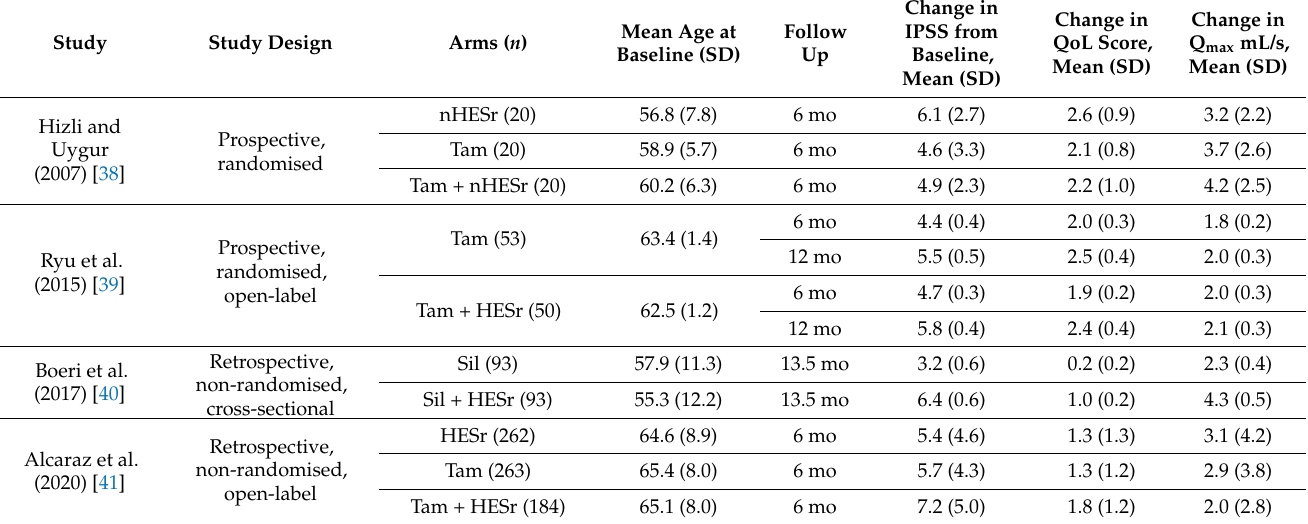
Table 1. Key features of included studies investigating HESr as a combination therapy with α -blockers in the management of